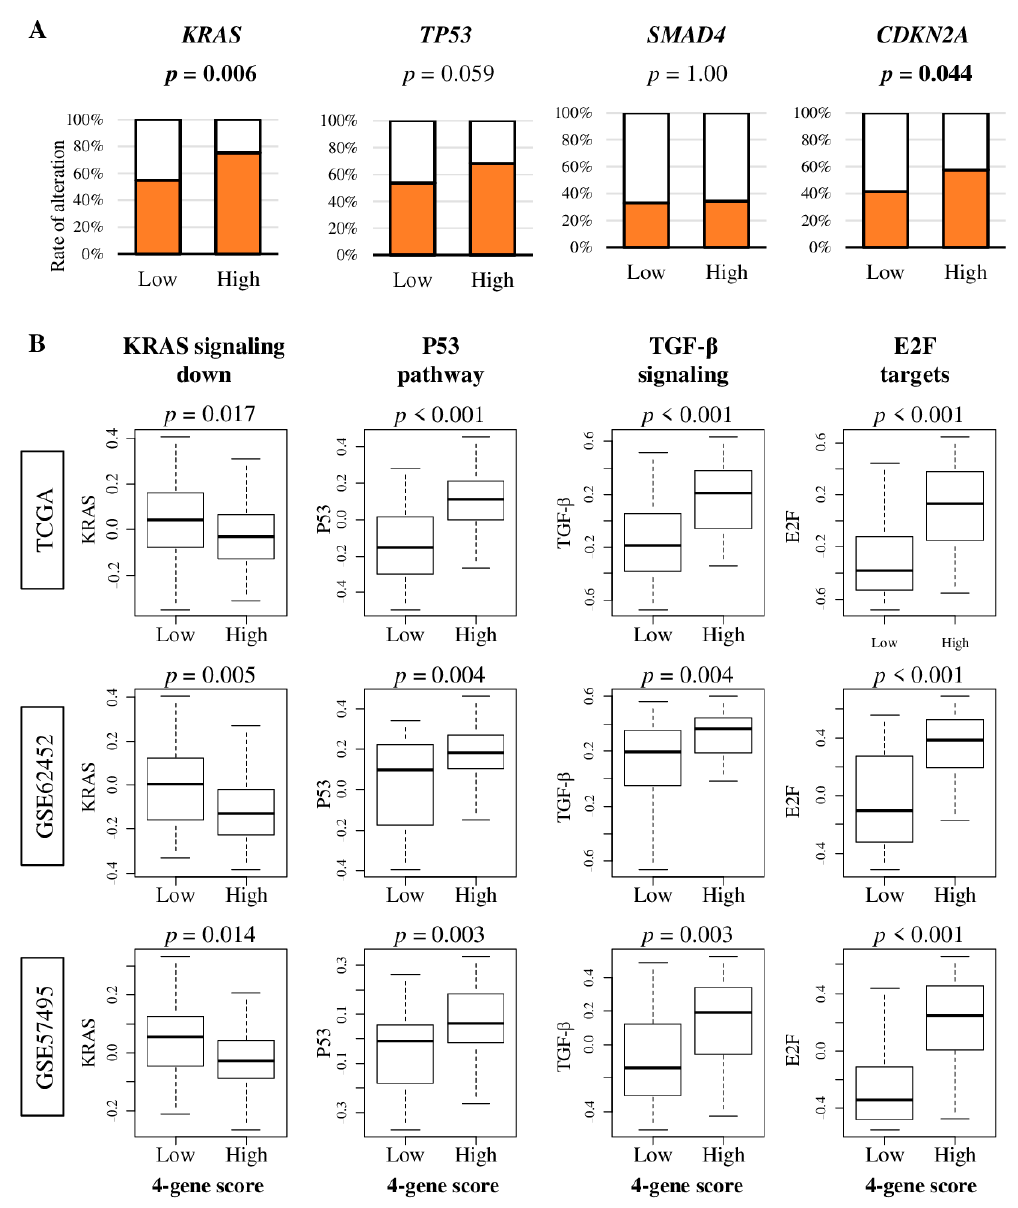
Figure 4. The association of the four-gene score with rate of KRAS , TP53 , SMAD4 , and CDKN2A gene alterations, and with signaling of KRAS , P53, transforming growth factor (TGF)- β , and E2F. ( A ) Bar plots of the percentage of patients with alteration of each genes in low- or high-four-gene-score groups. The Fisher’s exact test was used to calculate p values. ( B ) Boxplots of gene set variation analysis (GSVA) Hallmark gene sets, KRAS down-signaling, p53 pathway, TGF- β signaling, and E2F target by low- and high-four-gene-score group in the TCGA, GSE62452, and GSE57495 cohorts. Low- and high-four-gene score groups were divided by the median value of each cohort. A one-way ANOVA test was used to calculate p values. Tukey-type boxplots showed median and interquartile level values.